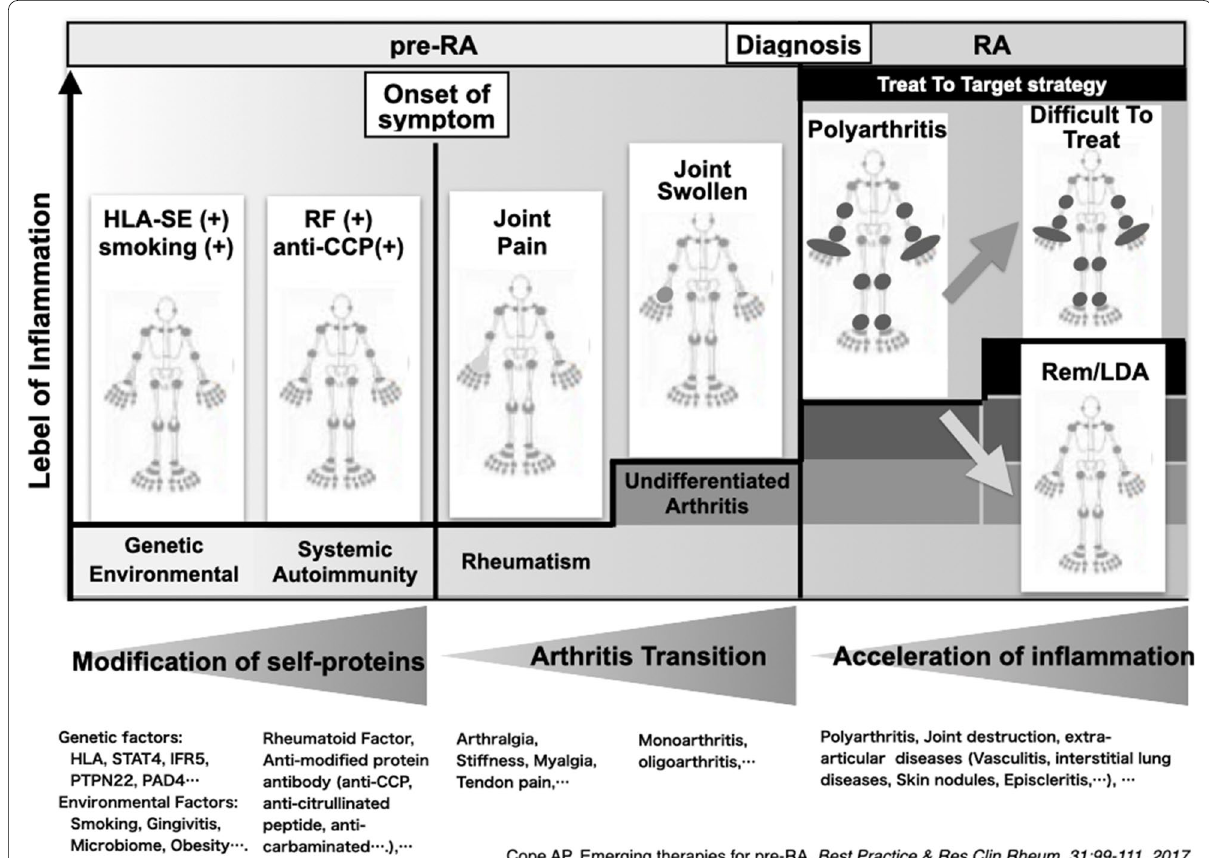
Fig. 5 Pre-disease stage RA and RA [70]. The y-axis indicates the relative level of inflammation, and the x-axis indicates the relative time from the cause to the development of RA and the disease course after